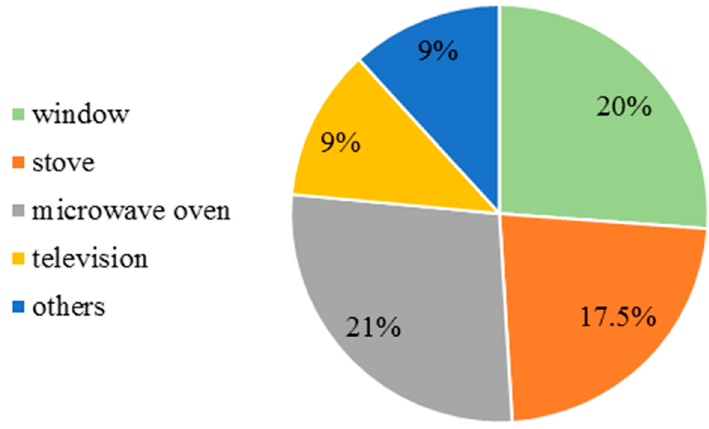
Figure 12. Typical heat sources near the refrigerator.